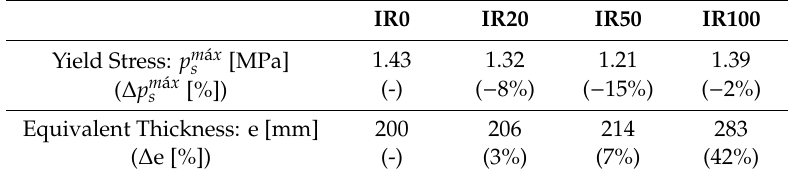
Table 6. Variation of yield stress and equivalent thickness when a similar sti ff ness criterion is adopted.